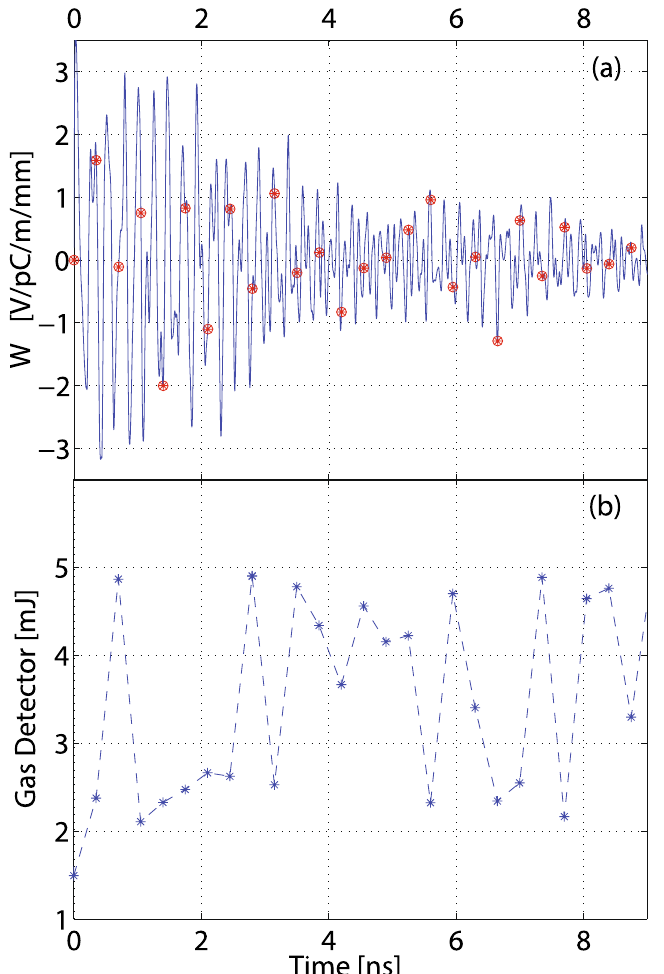
Figure 3. Transverse wakefields and their impact on the lasing process for short delays: ( a ) long-range transverse wakefield for the S-band accelerating structure. Red dots represent 350 ps sampling, ( b ) typical LCLS-I lasing energy performance as a function of the two-bucket delay (with no active trajectory